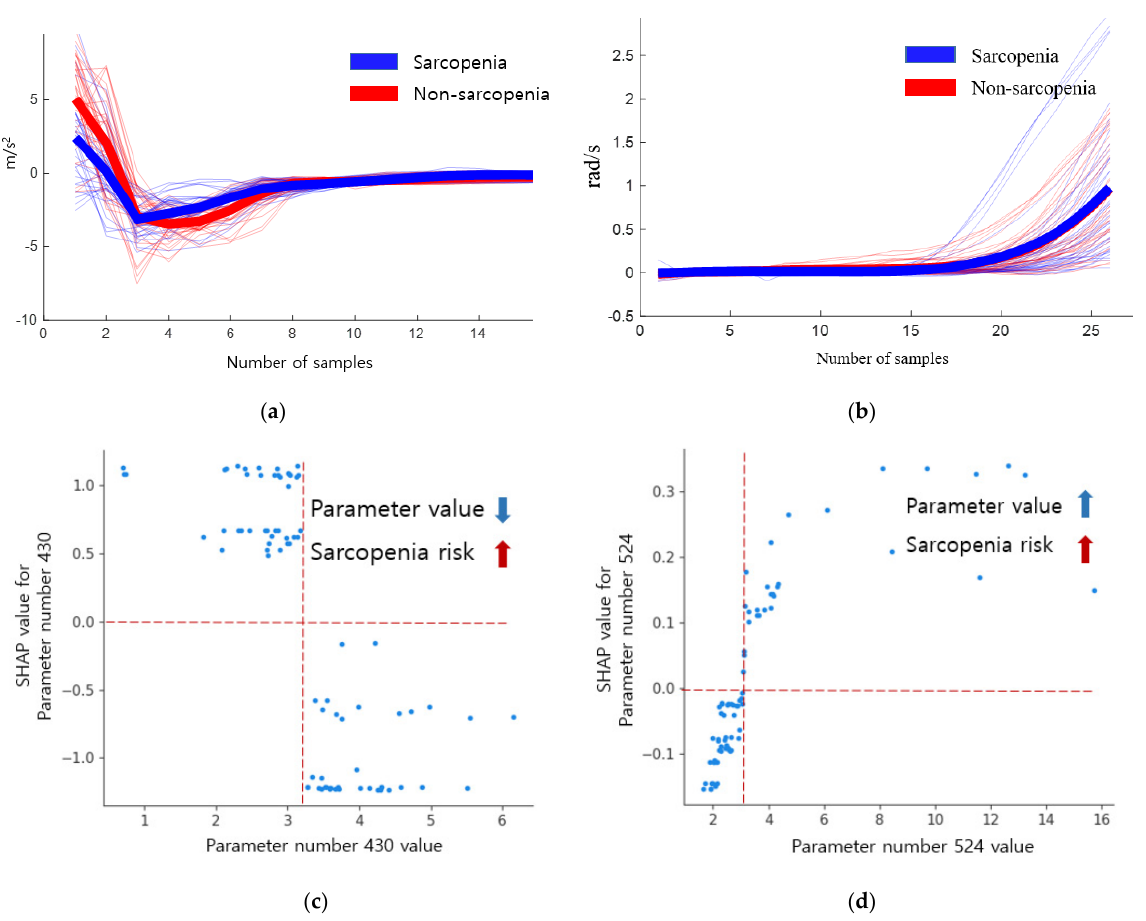
Figure 6. Inertial signals and SHAP dependence plots of descriptive statistical parameters 430 and 524 of sarcopenia. ( a ) Inertial signal 430. ( b ) Inertial signal 524. ( c ) SHAP dependence plot 430. ( d ) SHAP dependence plot 524.